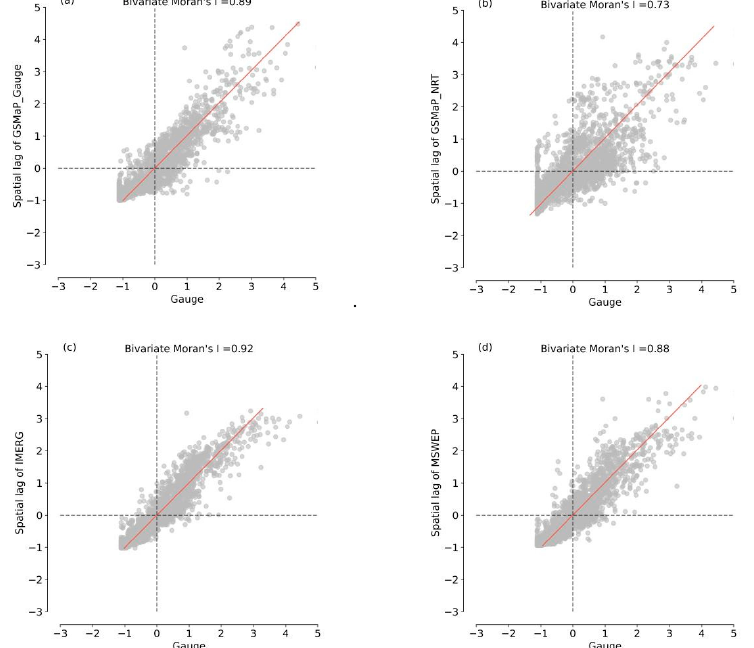
Figure 15. The global BMI scatter plot of R50 between the gauge observations and the four SPPs: ( a ) GSMaP_Gauge, ( b ) GSMaP_NRT, ( c ) IMERG, and ( d ) MSWEP.